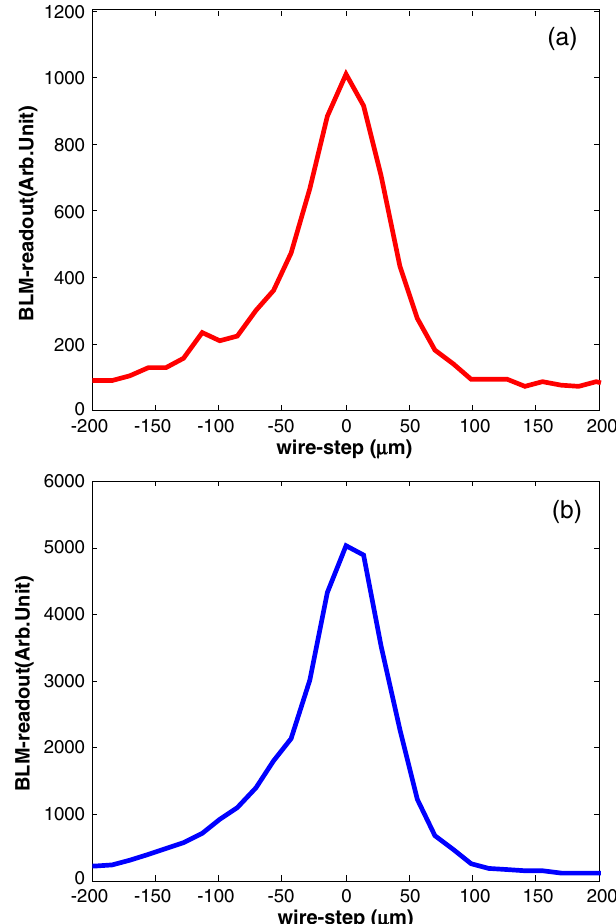
FIG. 16. Beam profile resulting from the scan of the FERMI electron beam with a 12 . 5 μ m Al ð 99 Þ ∶ Si ð 1 Þ wire (a) and a 5 μ m W wire (b) as detected by a BLM placed at a distance of 2.48 m from the WSC. The scan was performed at a motor-speed of 0 . 2 mm = s and at a beam energy of 1.325 GeV, charge 700 pC and 10 Hz repetition